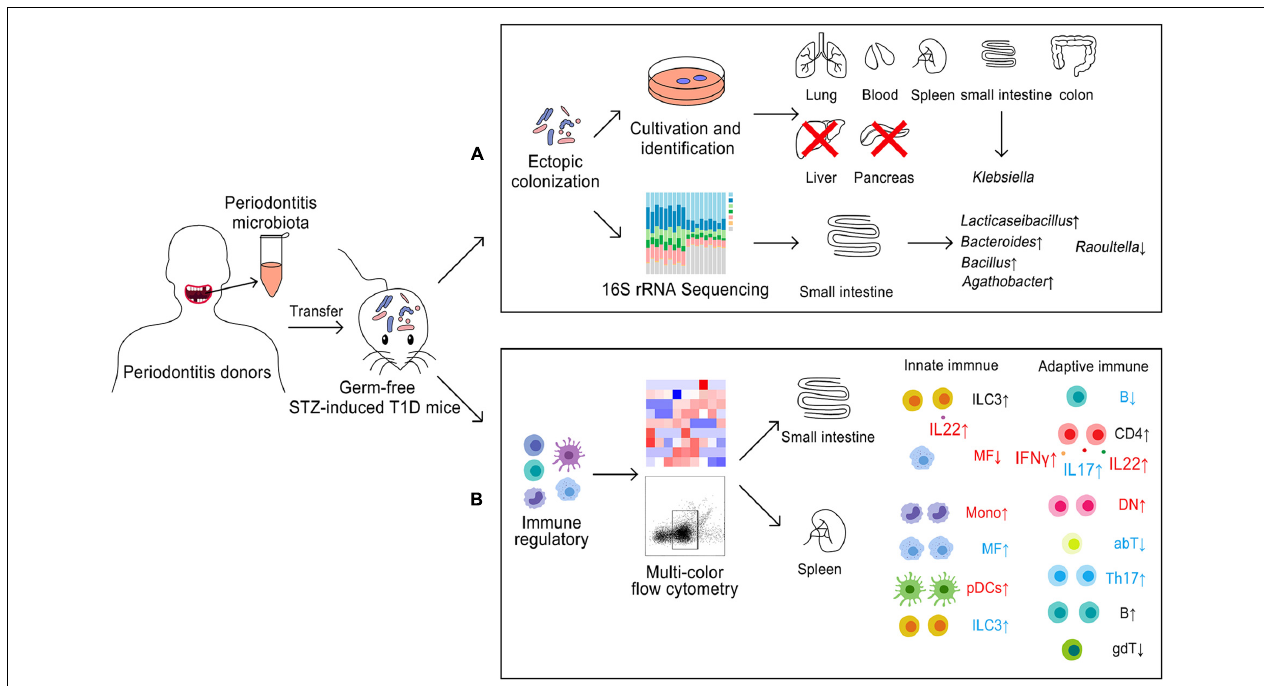
FIGURE 5 | Model for ectopic colonization and immune regulation of periodontitis microbiota in germ-free mice with STZ-induced T1D. (A) Ectopic colonization. (B) immune regulation; small intestine, local immunity; spleen, systemic immunity. Blue color meant about two times alteration and red color meant about three-times changes. ↑ , upregulation; ↓ ,